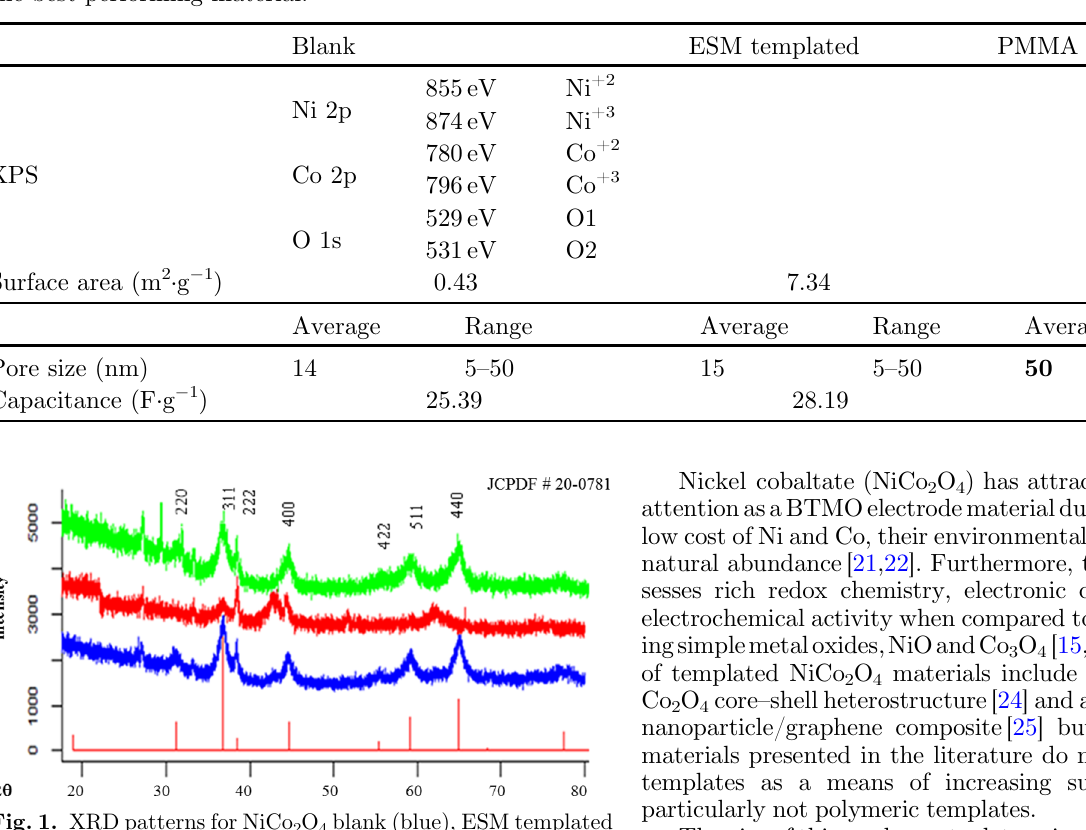
O electrode materials. Bold values represent 2 4